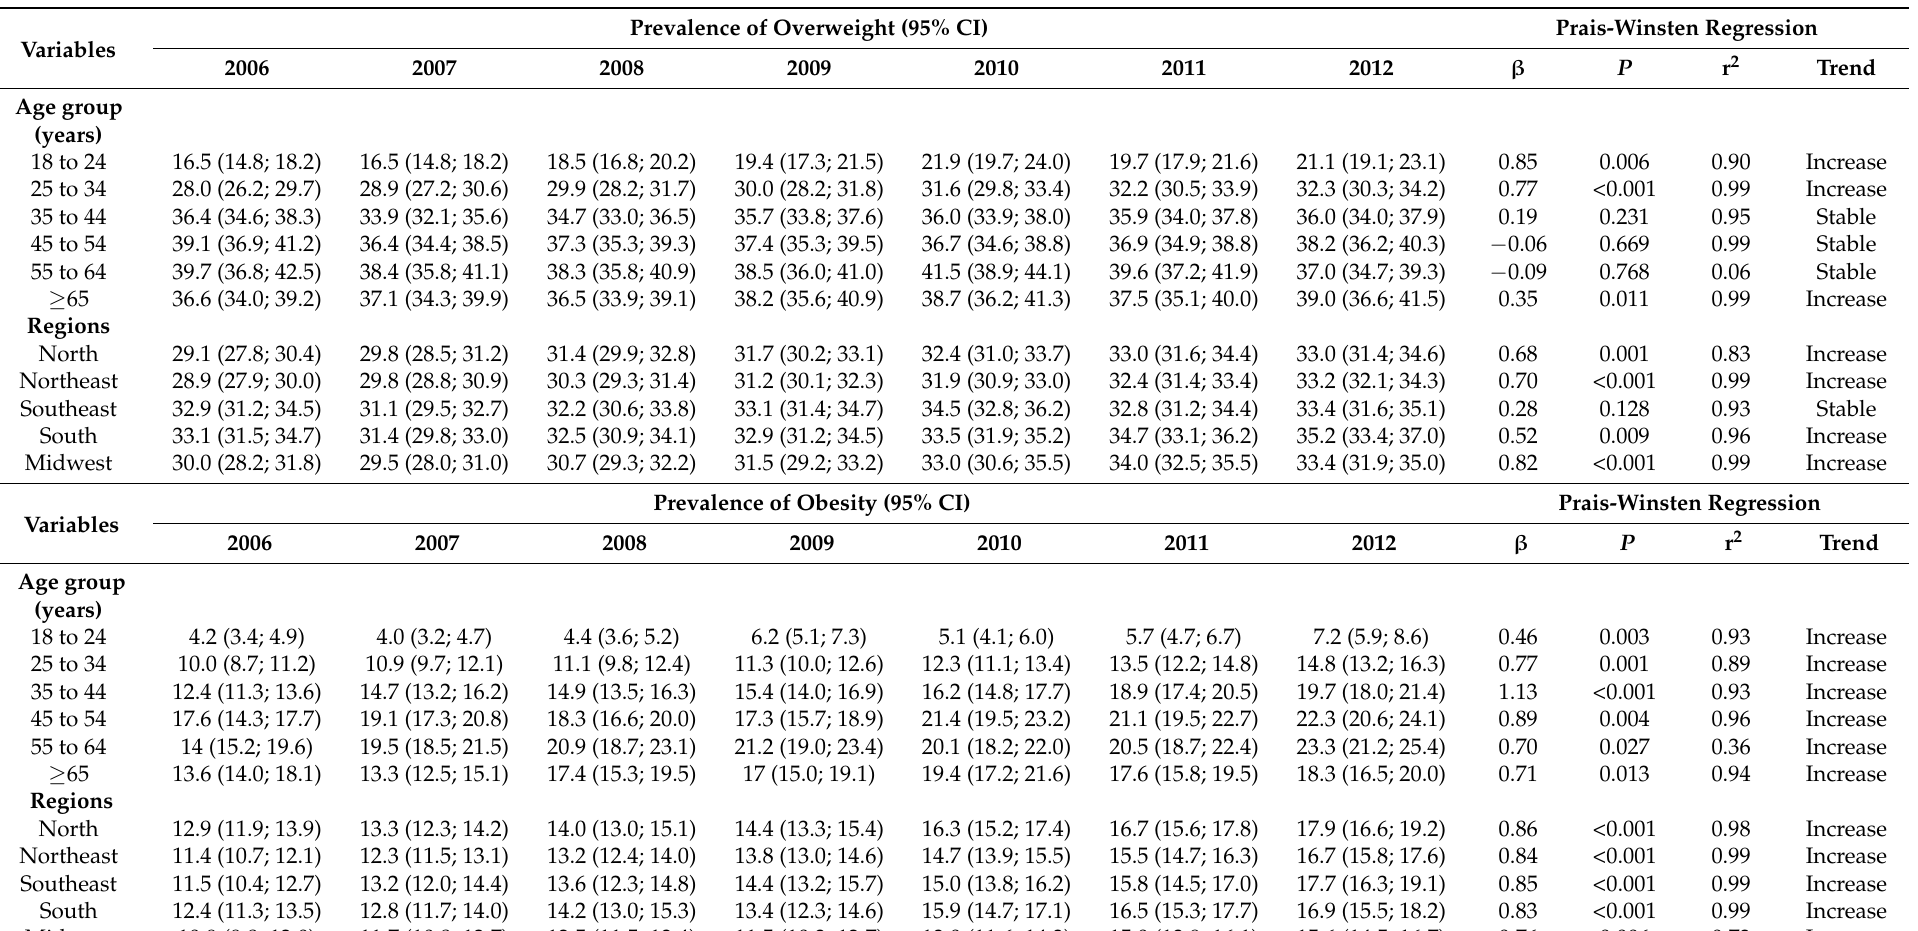
Table 5. Prevalence of overweight rate and obesity among adults, stratified by age group and regions of Brazil between 2006 and